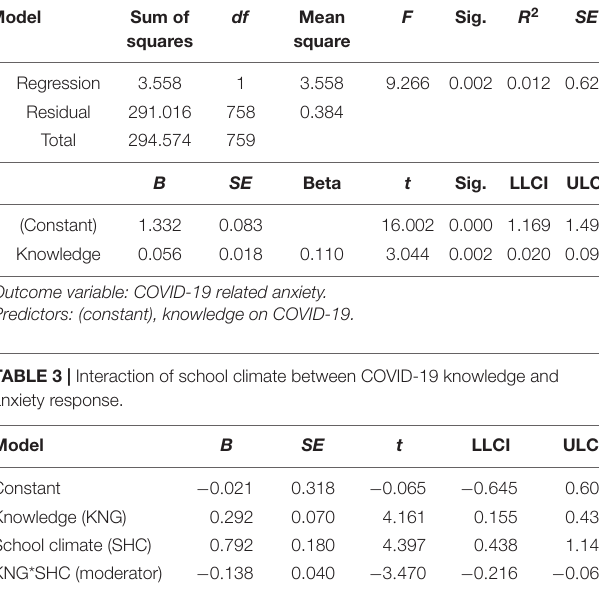
TABLE 2 | Model summary and regression coefficients.